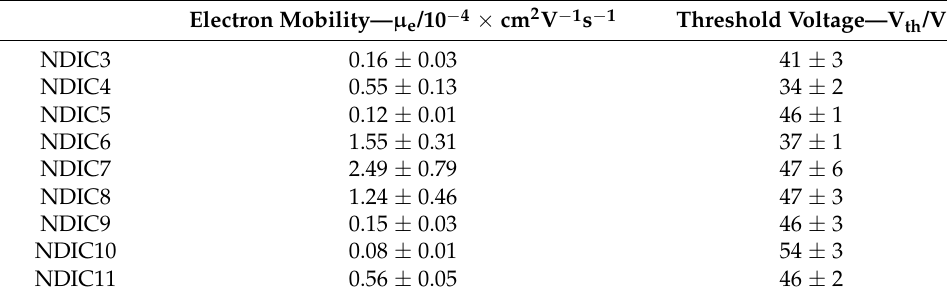
Table 3. Electron mobilities and threshold voltages of NDI-based